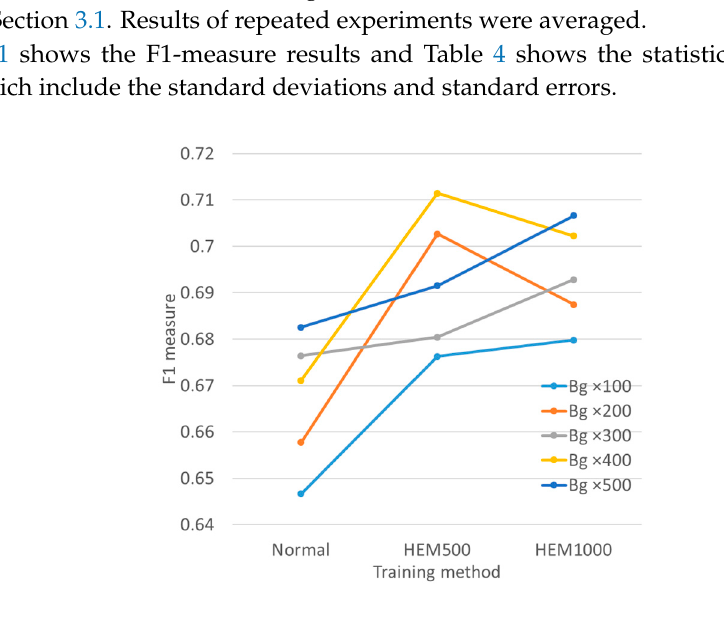
Figure 11. F1 scores in each condition. Our proposed method improved the scores in all cases over the normal method.